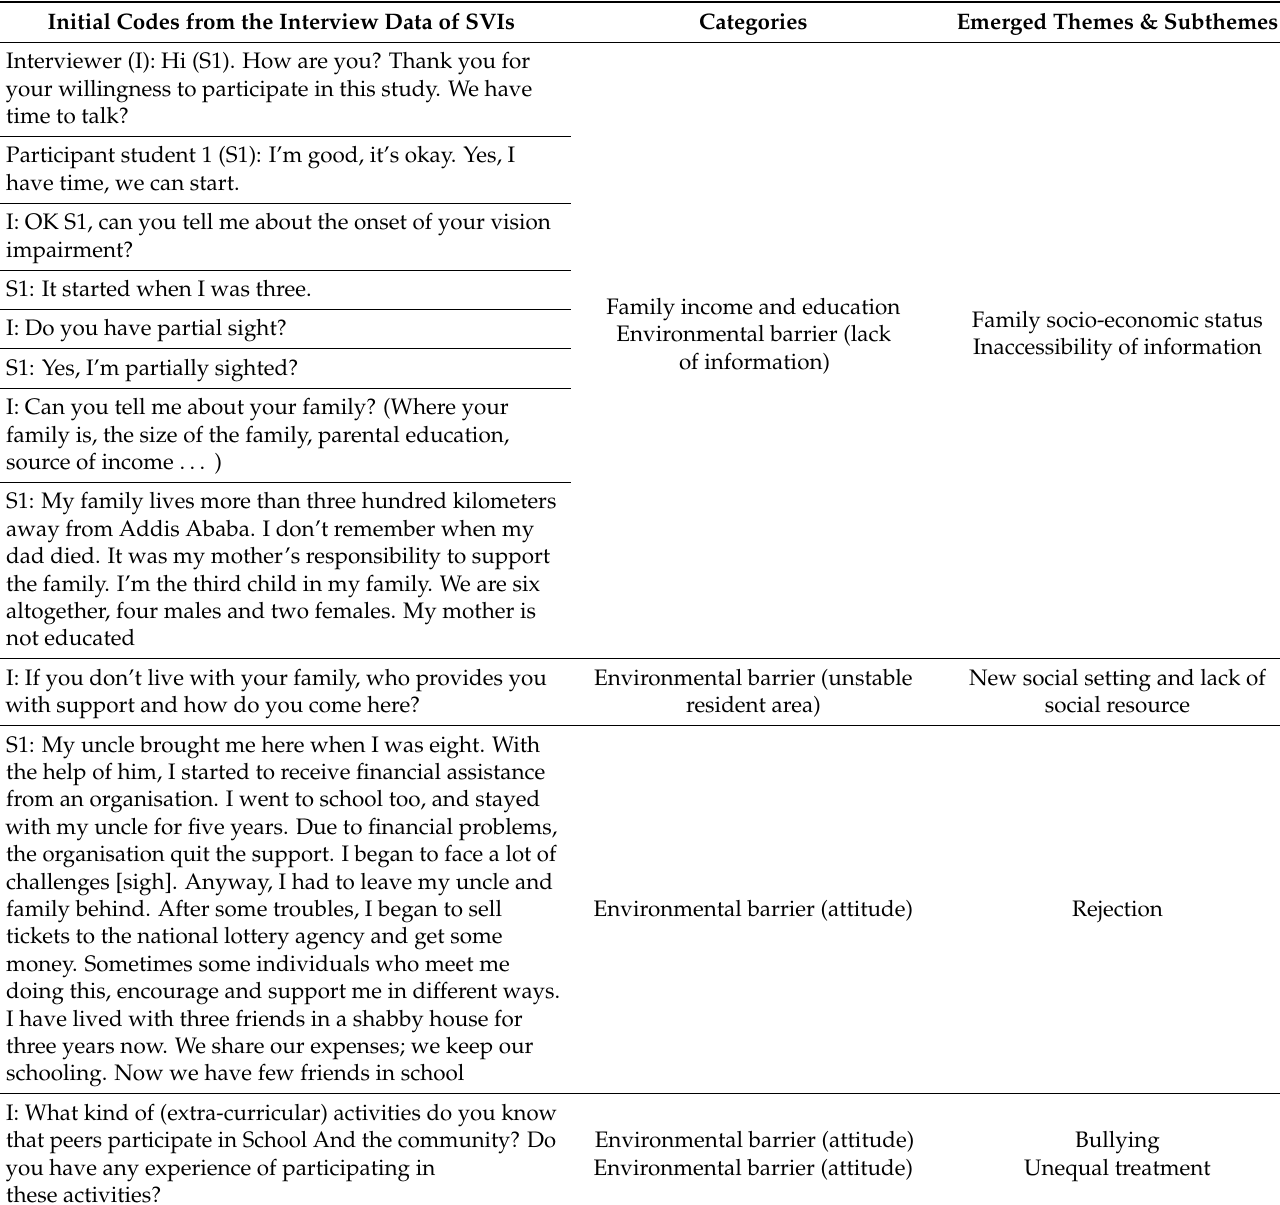
Table A1. Example Transcript: Semi-structured interview with SVIs–Student 1 (S1)–School A,